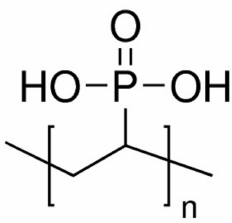
Figure 4. The structure of poly(vinyl phosphonic acid) (PVPA).